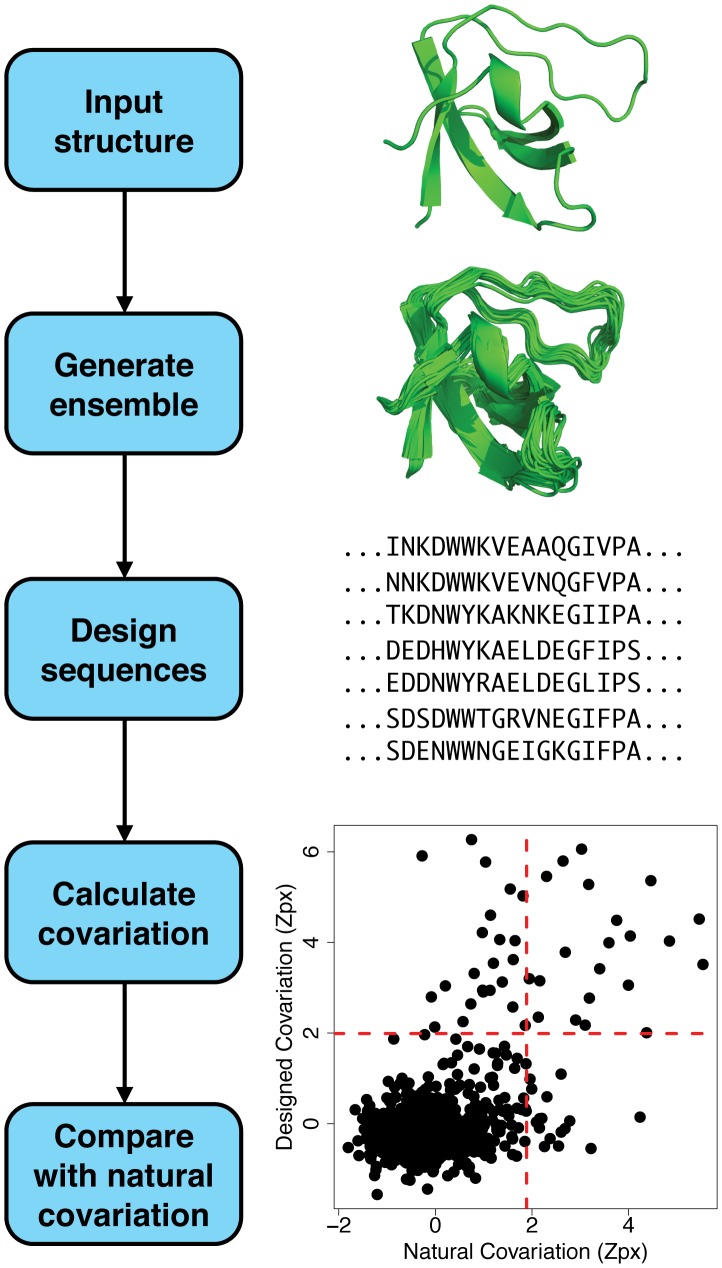
Flow chart of the computational strategy to compare natural and designed amino acid covariation.For each domain family (the SH3 domain in the example), a crystal structure of the domain is obtained from the Protein Data Bank. This structure is used as input to a protocol that generates a conformational ensemble of protein structures. Each structure in this ensemble is then input to a protocol that designs a low energy sequence consistent with the structure. Amino acid covariation is calculated for every pair of positions in the designed sequences, and the designed covariation is compared to the covariation seen among naturally occurring sequences with the same protein domain.